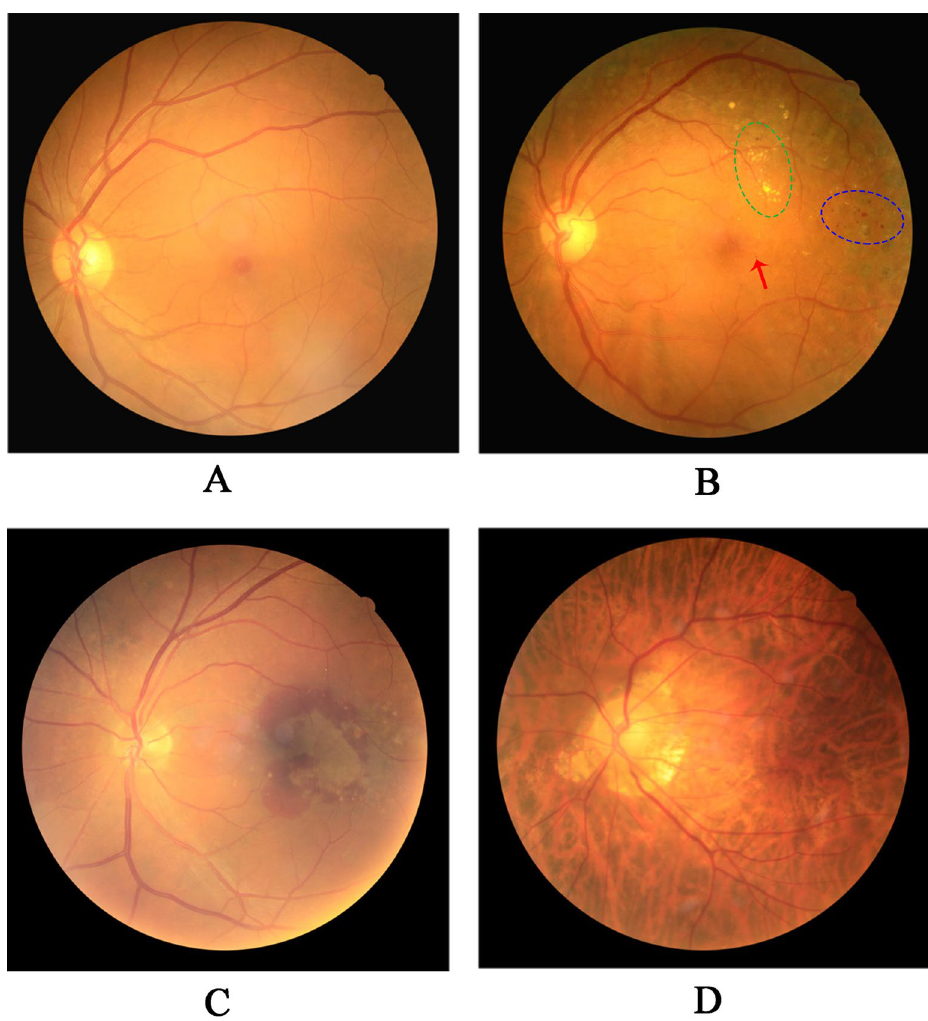
Figure 4. Typical fundus photographs in patients with DM. ( A ) Fundus photograph of a healthy individual; ( B ) Fundus photograph of a DR patient (blue circle indicates retinal hemorrhage, green circle indicates hard exudation, and red arrow indicates microaneurysms); ( C ) Fundus photograph of an age-related macular disease patient; ( D ) Fundus photograph of a tessellated retina